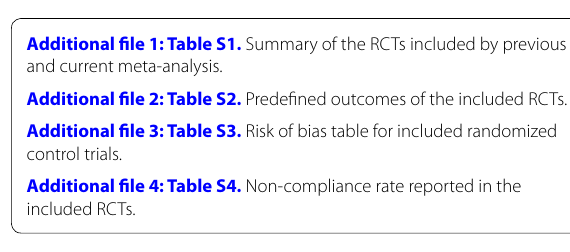
Additional file 2: Table S2. Predefined outcomes of the included RCTs. Additional file 3: Table S3. Risk of bias table for included randomized control trials. Additional file 4: Table S4. Non‑compliance rate reported in the included